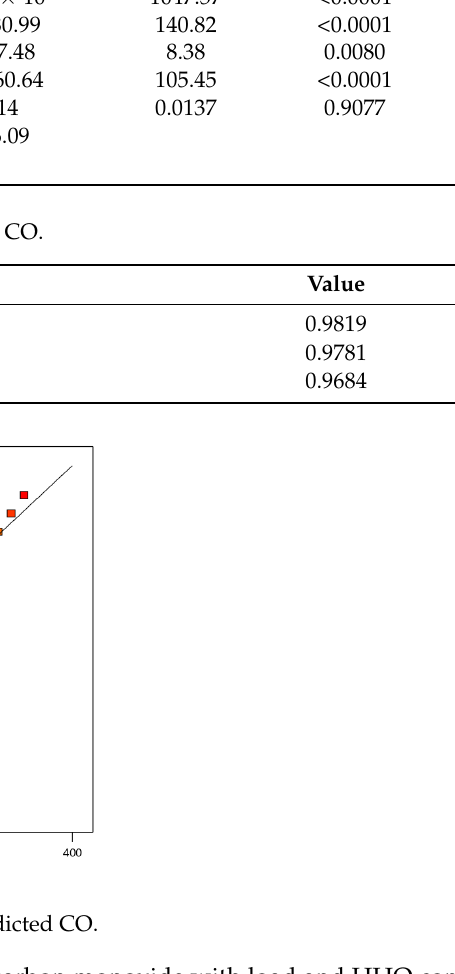
Figure 5. Comparison of actual and predicted BSFC.